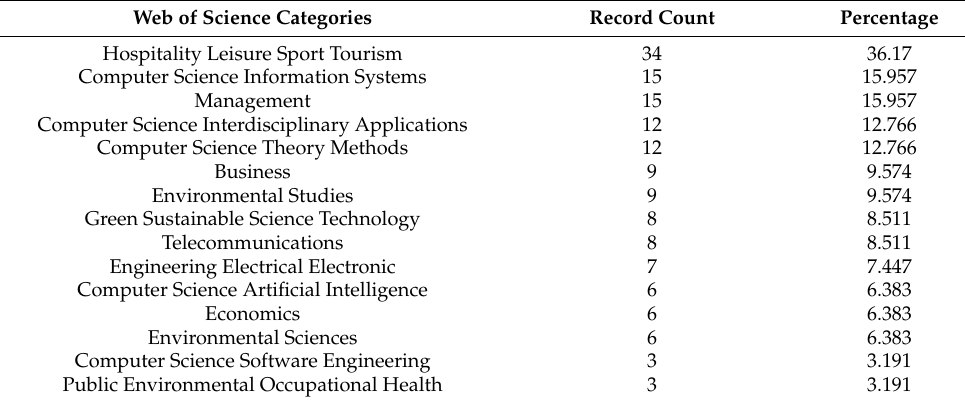
Table 1. Selected journals and their record